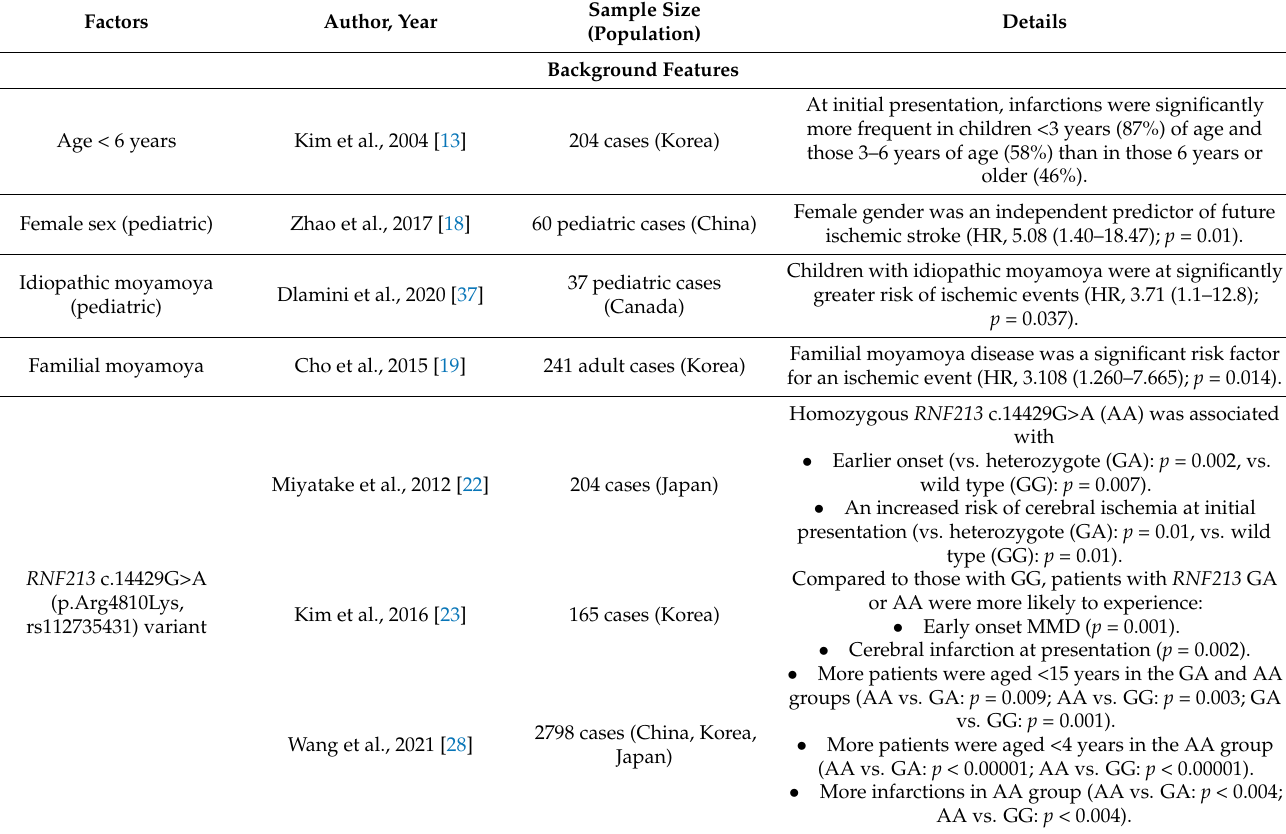
Table 1. Clinical factors associated with ischemic onset moyamoya